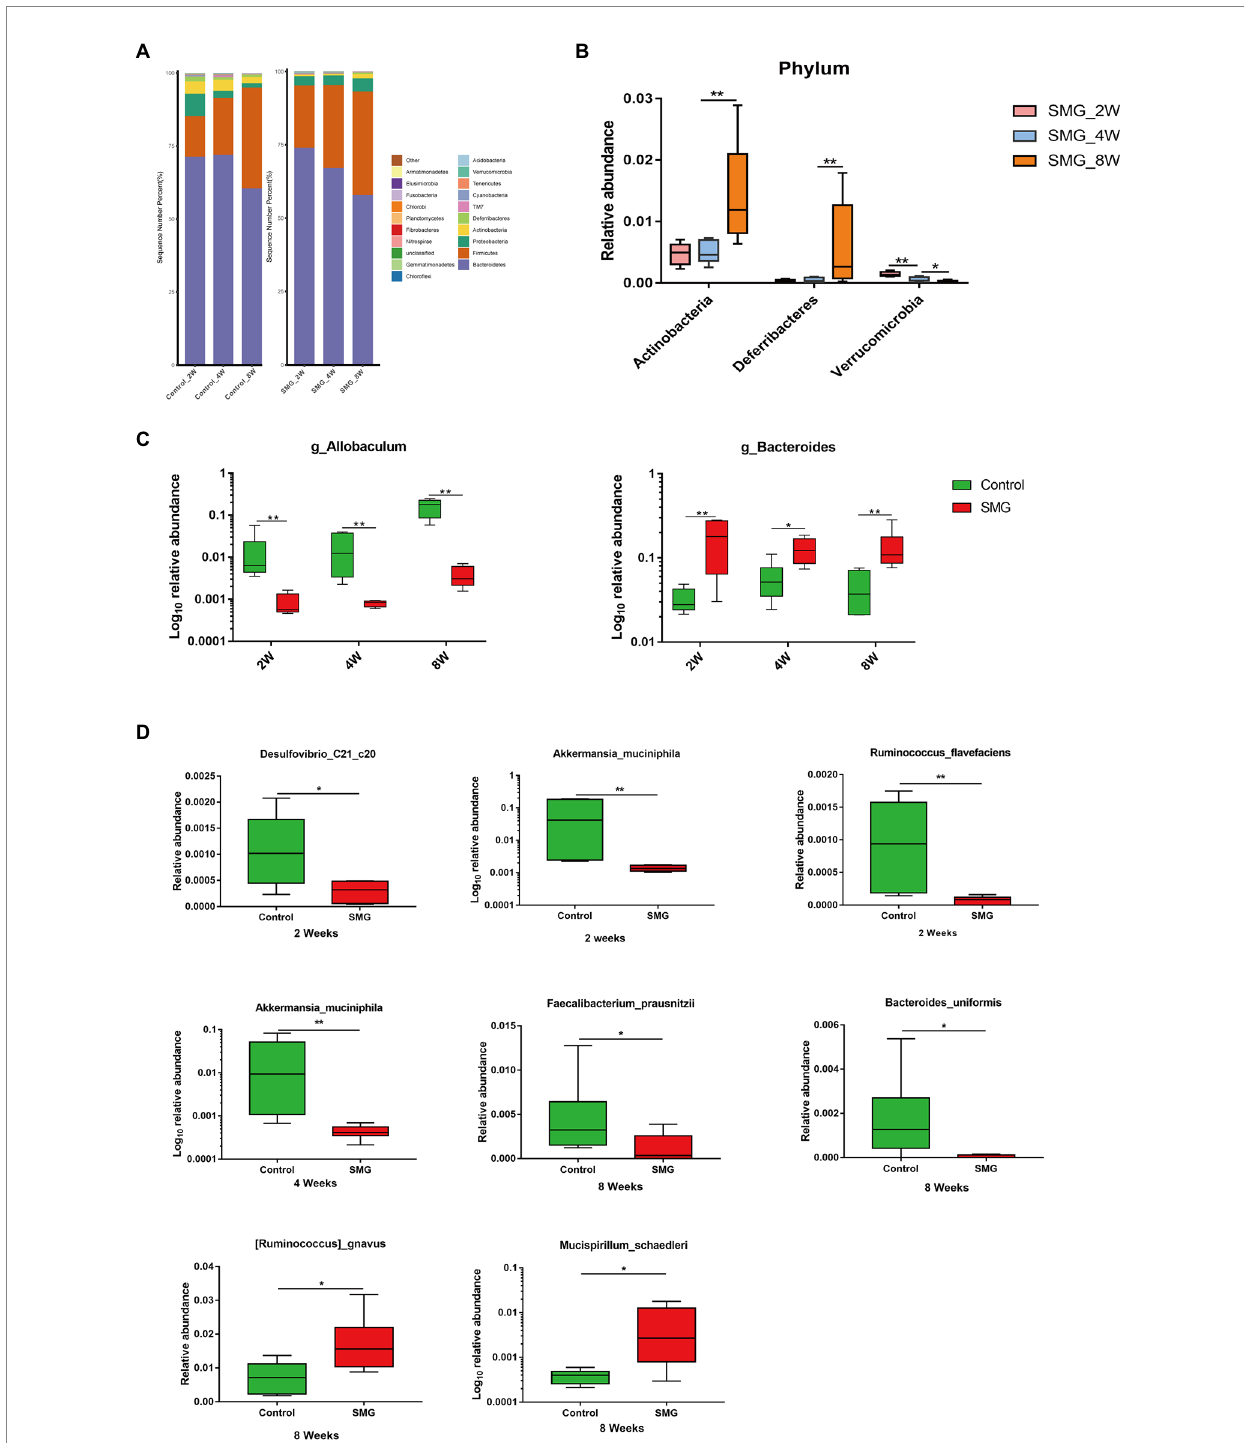
FIGURE 2 Taxonomic characterization of the gut microbiota in SMG mice at week 2, 4 and 8. (A) The column chart of the relative abundances of species in two groups the at phylum level. Differential bacteria in feces at phylum (B) , genus (C) , and species level (D) . * p < 0.05, ** p <